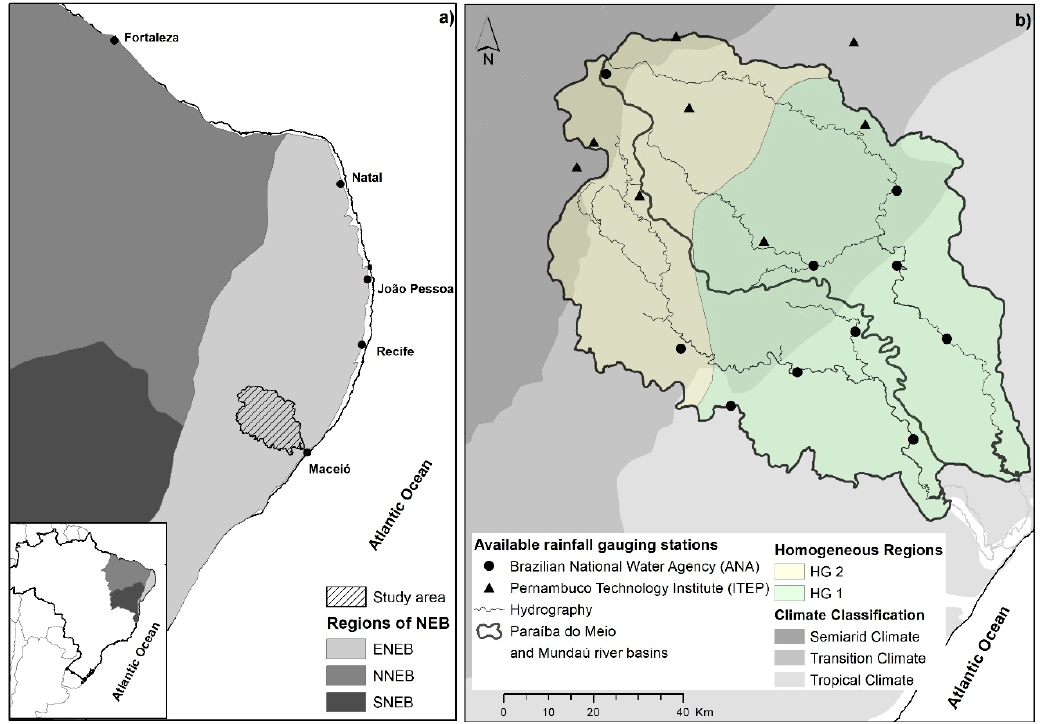
Figure 1. ( a ) the different precipitation regions of NEB (NNEB-medium gray, ENEB-light gray and SNEB-dark gray) and the overview location of the study area in NEB and Brazil (adapted from [21]). ( b ) the study area (Paraíba do Meio and Mundaú river basins) with the precipitation homogeneous regions adapted from [29]. The climate classification (shades) is in accordance with [33].